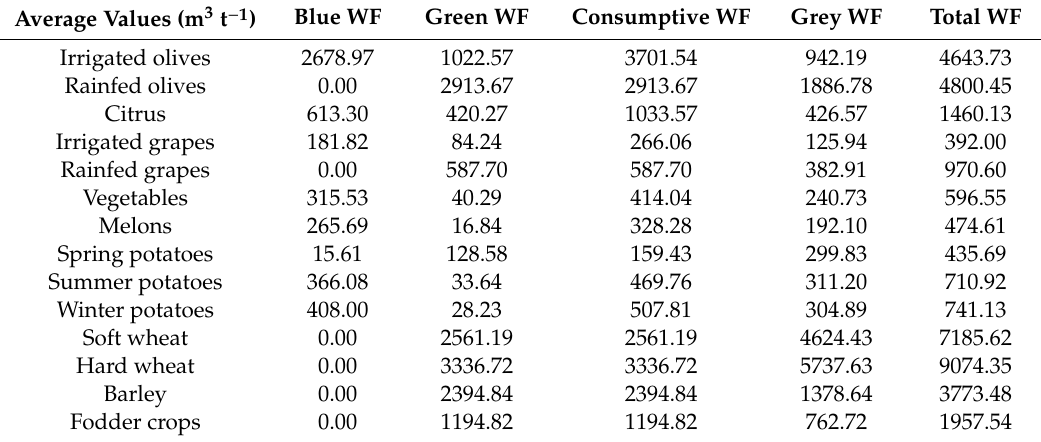
Table 1. Average WFs for the period 2000–2014 (m 3 t − 1